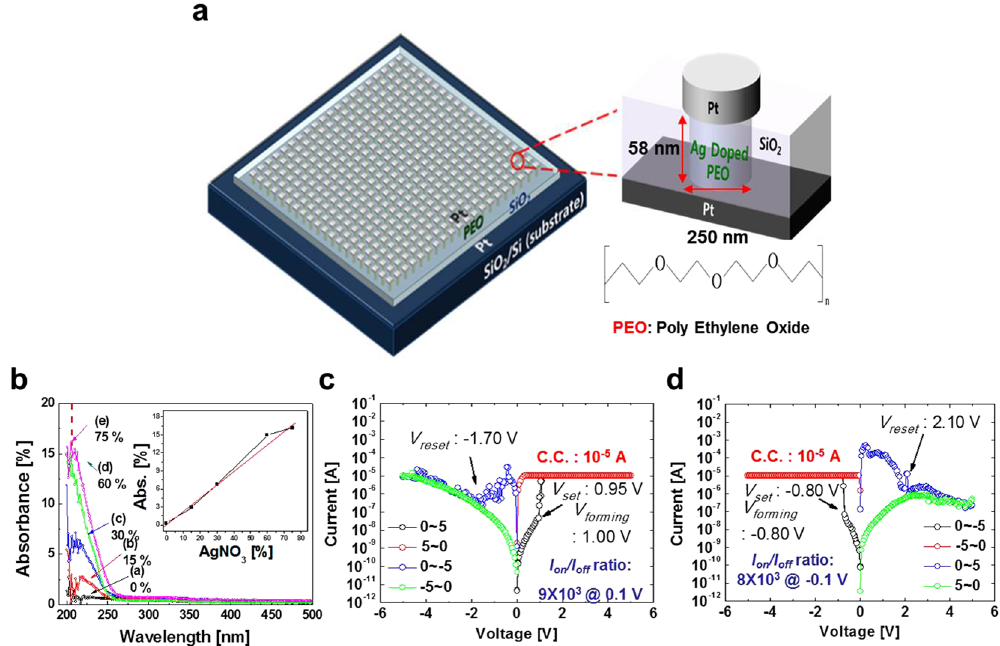
Figure 1. Bipolar switching characteristics of Ag-doped PEO polymer-electrolyte based CBRAM cell. ( a ) Schematic device structure of CBRAM cells, ( b ) dependence of UV absorption on Ag doping concentration in the PEO polymer electrolyte, ( c ) I–V curve of CBRAM cell while electro-forming at a positive applied bias, and ( d ) I – V curve of CBRAM cell while electro-forming at a negative applied